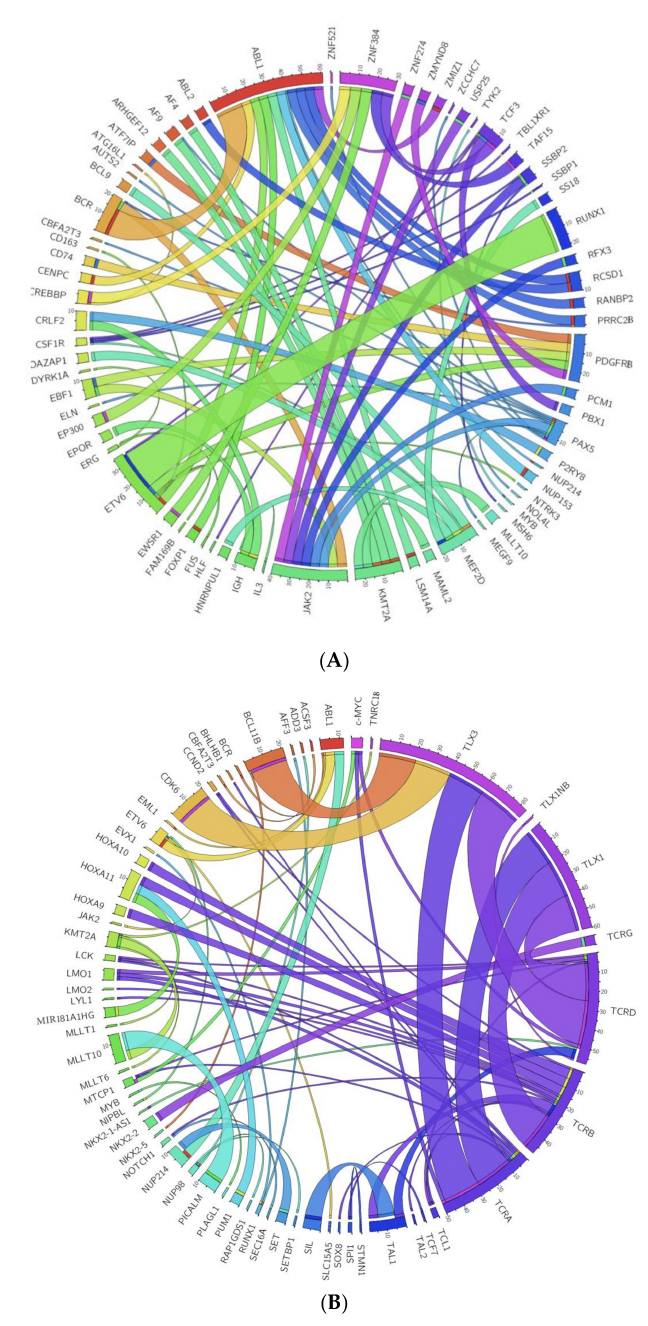
Figure 3. ( A ) New fusion genes identified by NGS approaches in B-ALL. Plot of new fusion genes identified by NGS approaches and their frequencies in B-cell acute lymphoblastic leukemia. ( B ) New fusion genes identified by NGS approaches in T-ALL. Plot of new fusion genes identified by NGS approaches and their frequencies in T-cell acute lymphoblastic